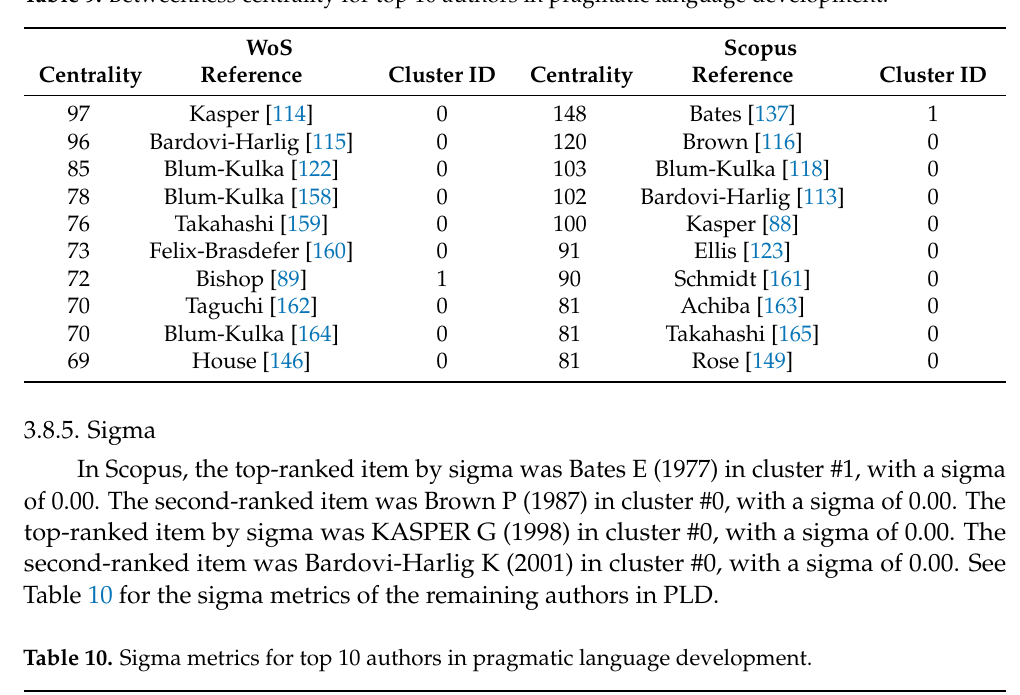
Table 9. Betweenness centrality for top 10 authors in pragmatic language development.